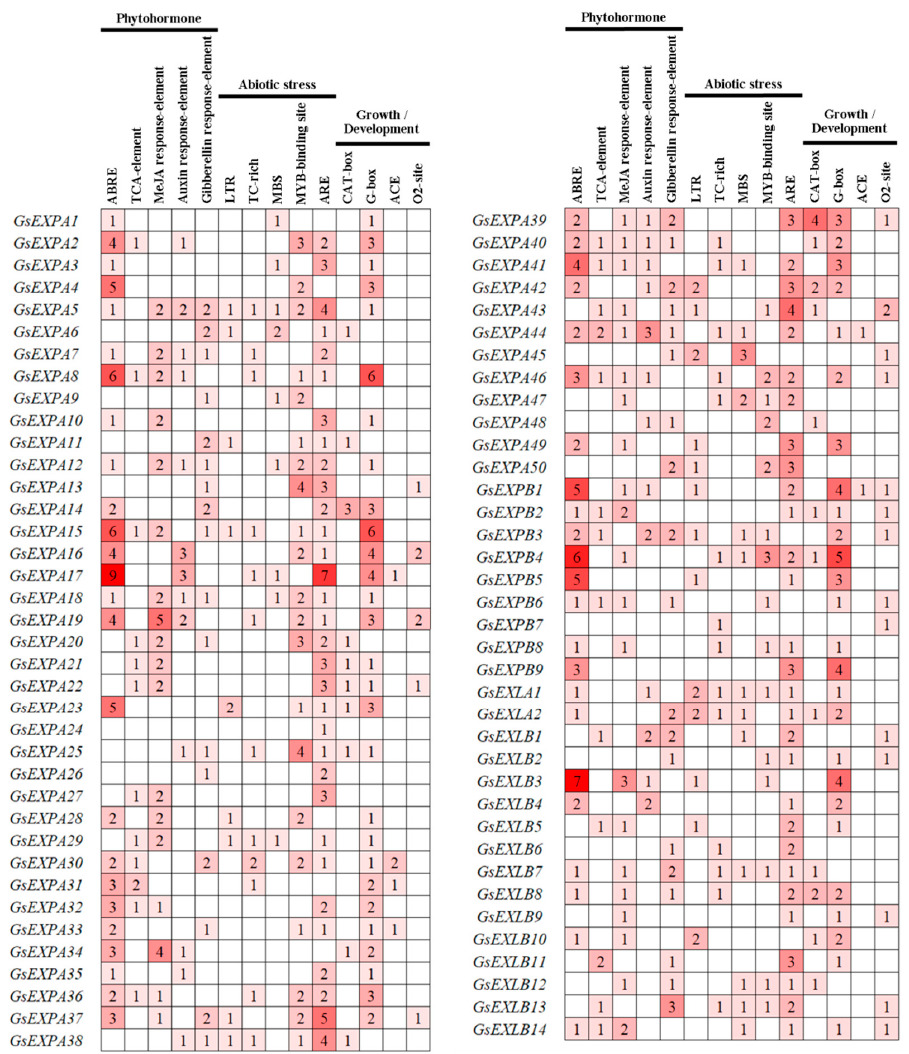
Figure 4. Promoter analysis results of wild soybean expansin family members.